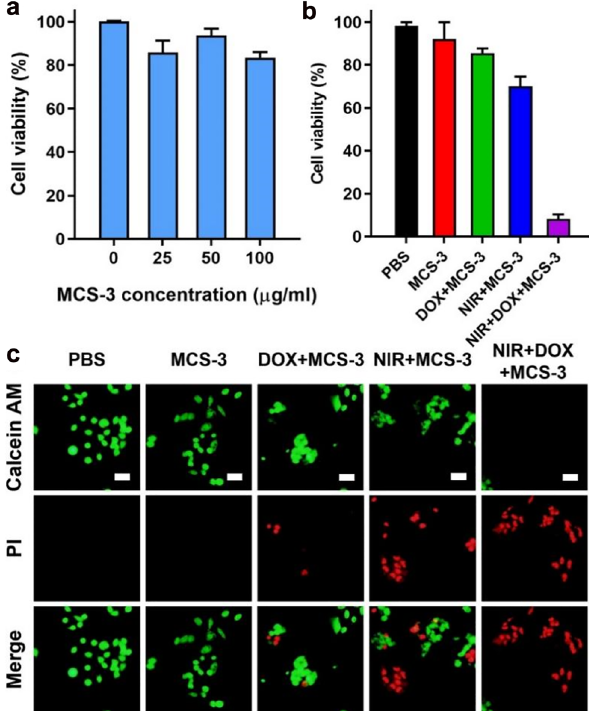
Figure 5: CCK-8 assay results of KHOS cells incubated with MCS-3 under various concentrations ranging from 0 to 100 μ g/mL for 24 h (a). In vitro cancer cell death after NIR photothermal ablation under different formulations (50 μ g/mL) (b). Representative fluorescent microscopic images with Calcein AM/PI staining of live cells (green) and dead cells (red) from the corresponding formulations (c). All scale bars are 25 μ